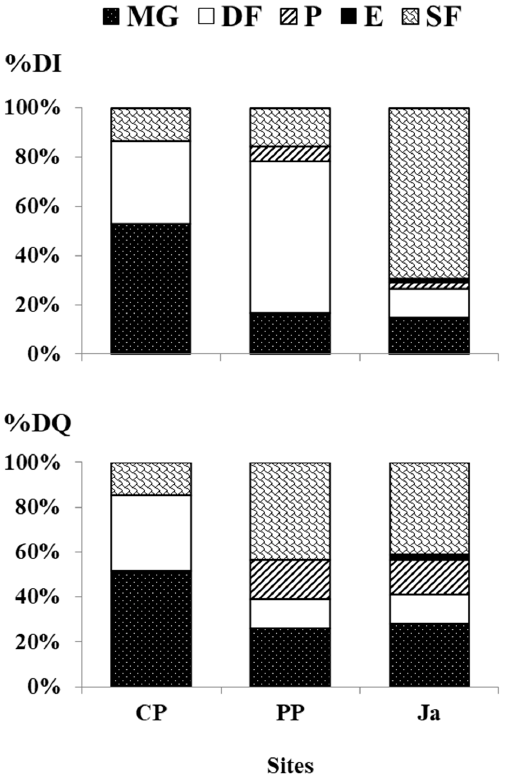
Figure 2. Trophic contribution of each feeding guild (MG micro- and macro-grazers, DF deposit feeders, P predators, E ectoparasites, SF suspension feeders) to quantitative (%DI) and qualitative (%DQ) dominances, obtained by pooling data of the three replicates per each site (CP Cabo de Palos, PP Punta Prima and Ja J á